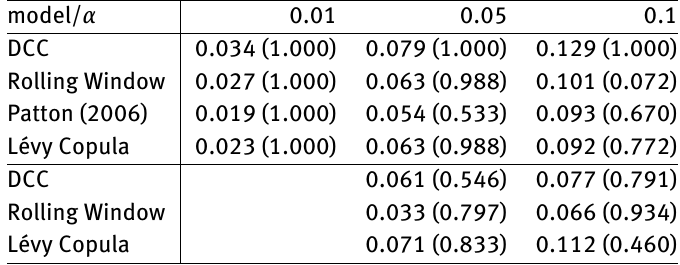
Table 2: VaR performance of the IBM-Google (top panel) and ExeCoin-SocialXBot (bottom panel) portfolios under different mod- els and different α . p -values of the Kupiec test in